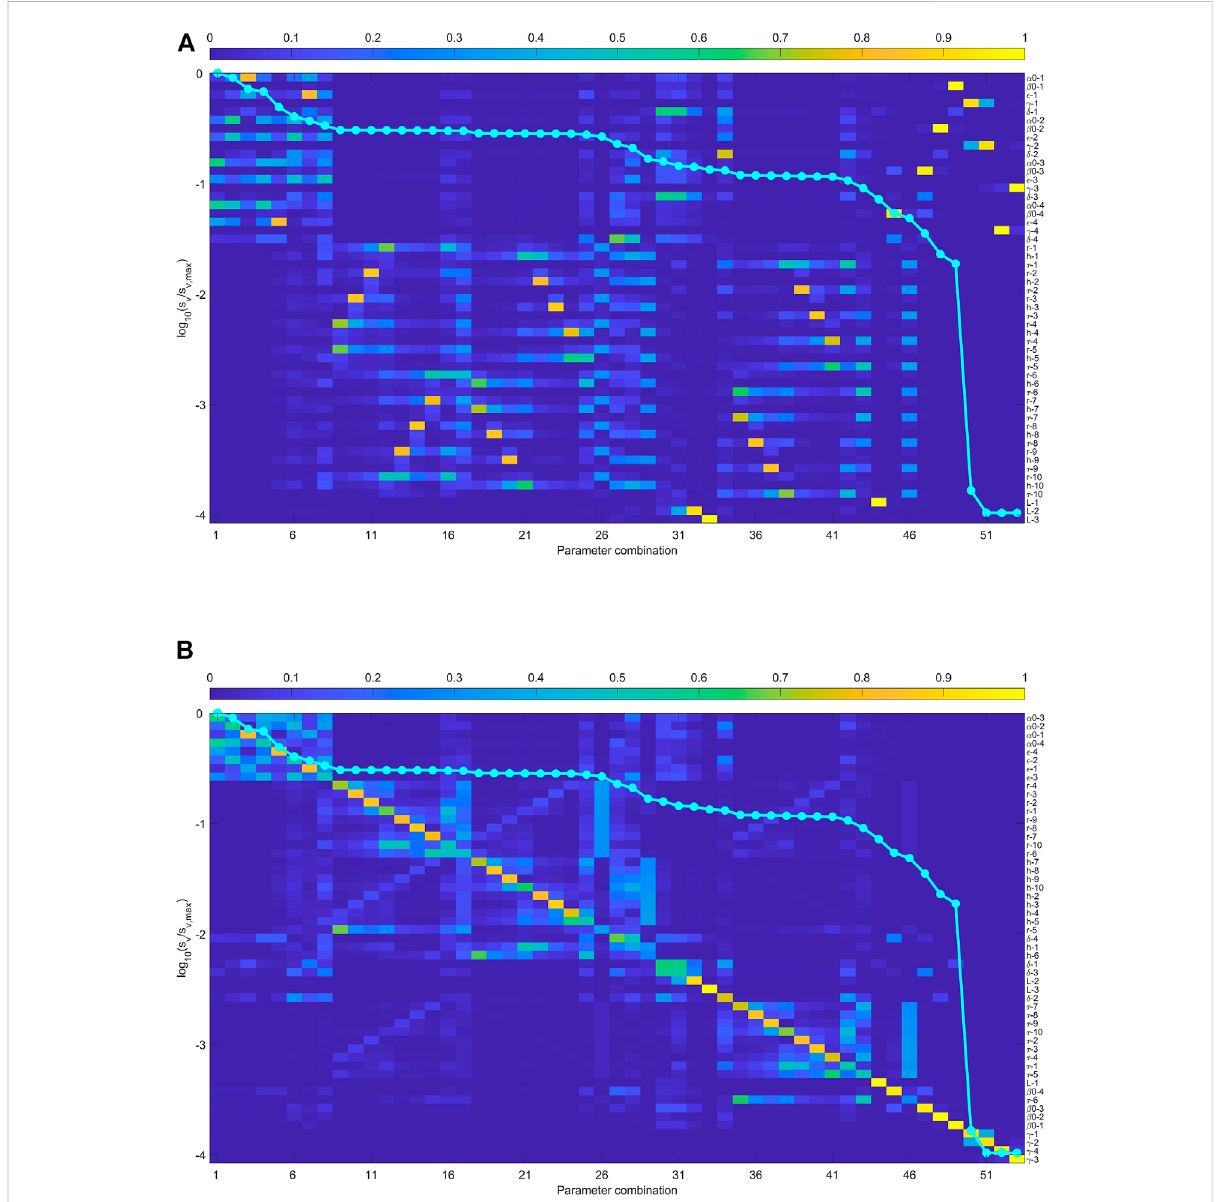
FIGURE 3 (A) The sensitivity analysis of the joint inversion using qP arrival times in the downhole array. The anisotropic is represented by Thomesen parametrization. (B) therowsofeigenvectormatrixaresortedtomakeitdiagonallydominantaspossible.Thesingularvaluesclosetozeromeansthe parameters on the right do not contribute to the observed